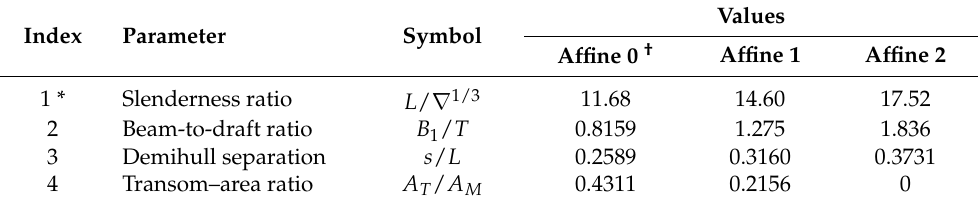
Table 2. Affine transformations of the